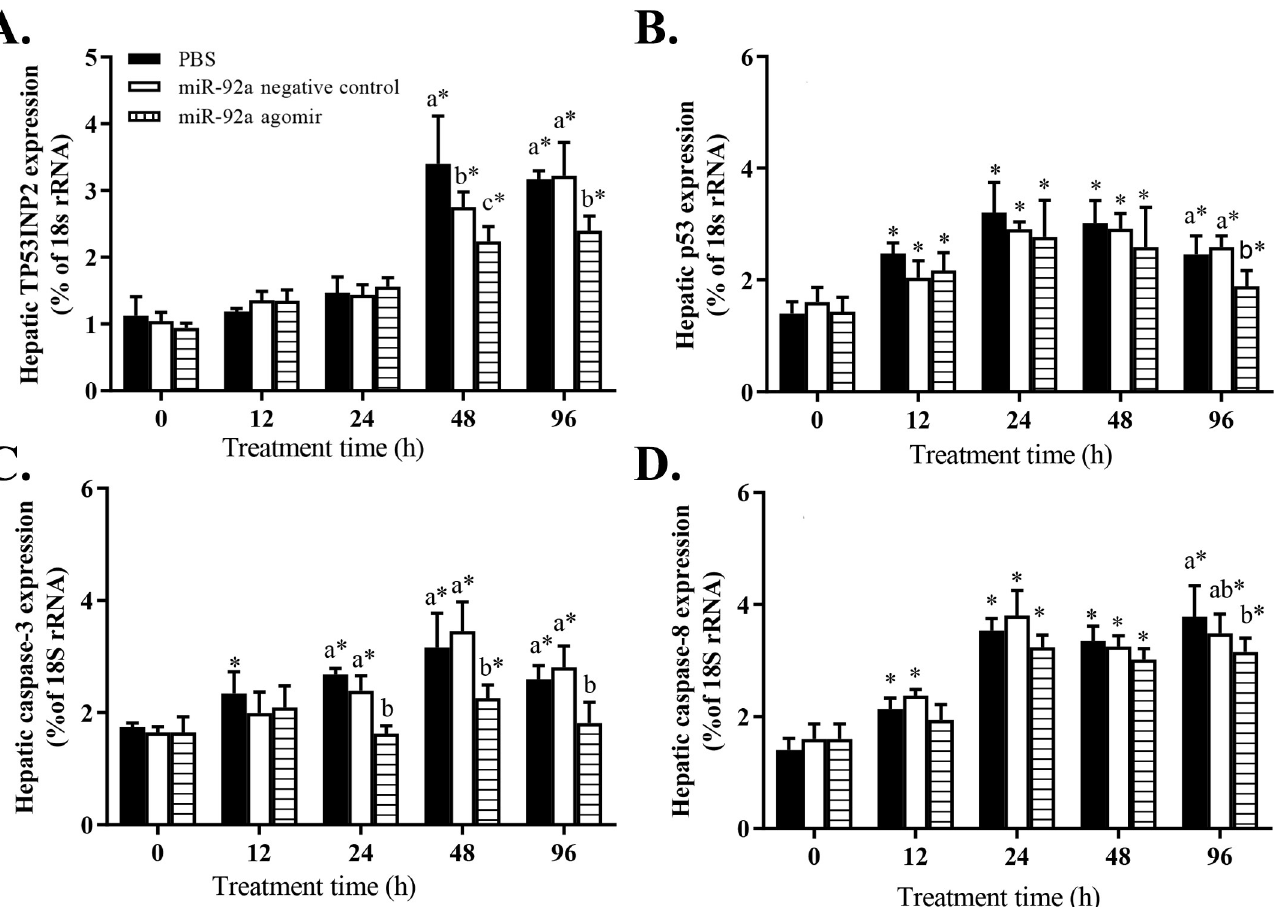
Fig 7. Effect of promoting miR-92a expression on transcript levels p53-inducible nuclear protein 2 (A), p53 (B), caspase-3 (C), and caspase-8 (D) in GIFT under hypoxia stress. At 12 h after injection with miR-92a agomir or PBS (control), juveniles were subjected to hypoxia stress for 96 h. Based on relative expression level in control group at 0 h, relative expression levels of mRNAs in each experimental group were determined by 2 - ΔΔ CT method. � Indicates significant differences between pre- and post- injection in the same experimental group (independent samples t test; P < 0.05). Different lowercase letters indicate significant differences among different treatments at each sampling point (Duncan’s multiple comparison; P <